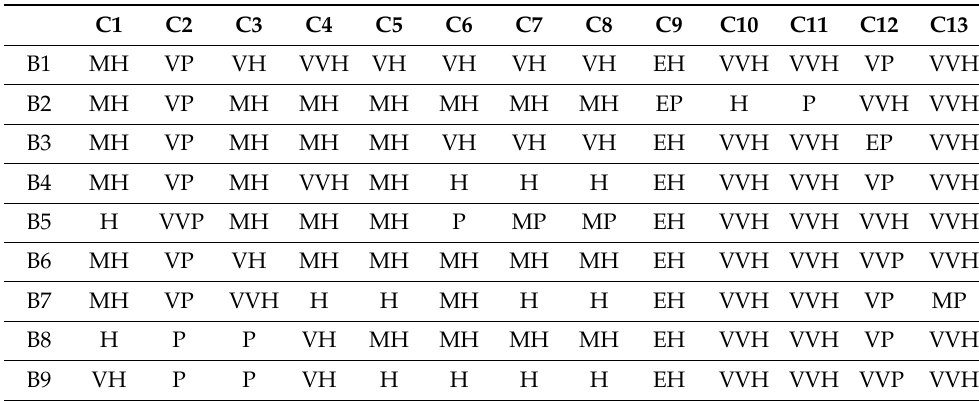
Table A2. Assessment of alternatives by E2.